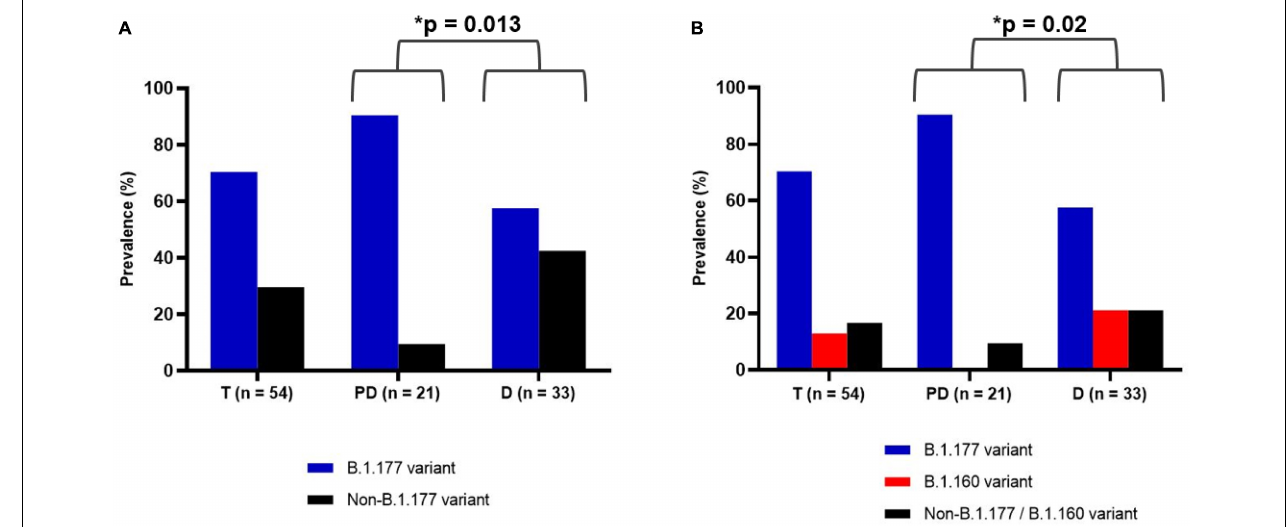
FIGURE 2 | Prevalence of SARS-CoV-2 variants among the 54 samples during the whole assayed period of this study (T), before December 2020 (pre-December group, PD) and in December 2020 (December group, D). The number of samples is given in the abscissa. (A) Prevalence of B.1.177 variant (blue) and non-B.1.177 variant (black). (B) Prevalence of B.1.177 (blue), B.1.160 (red), and non-B.1.177/B.1.160 variant (black). The asterisk indicates a statistically significant difference ( p -value given by the Fisher’s exact test, see section “Materials and